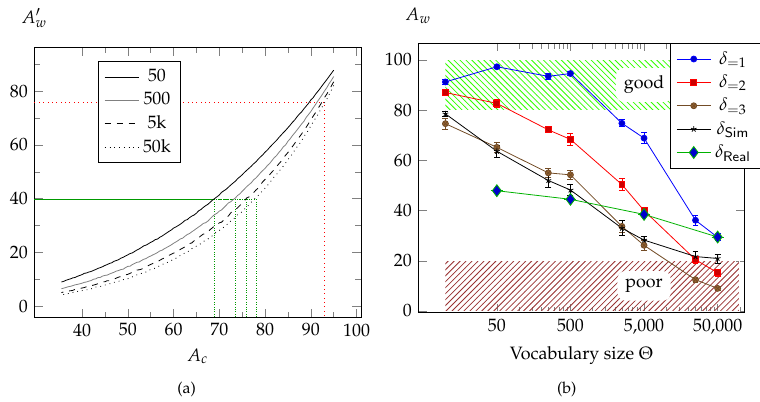
Figure 11. ( a ) Expected relation of the character recognition accuracy A c and direct word recognition accuracy A 0 w for different vocabulary sizes. ( b ) Influence of the vocabulary size and error based Levenstein distance δ on the word accuracy A w . Series δ Sim represents the simulated statistical error,